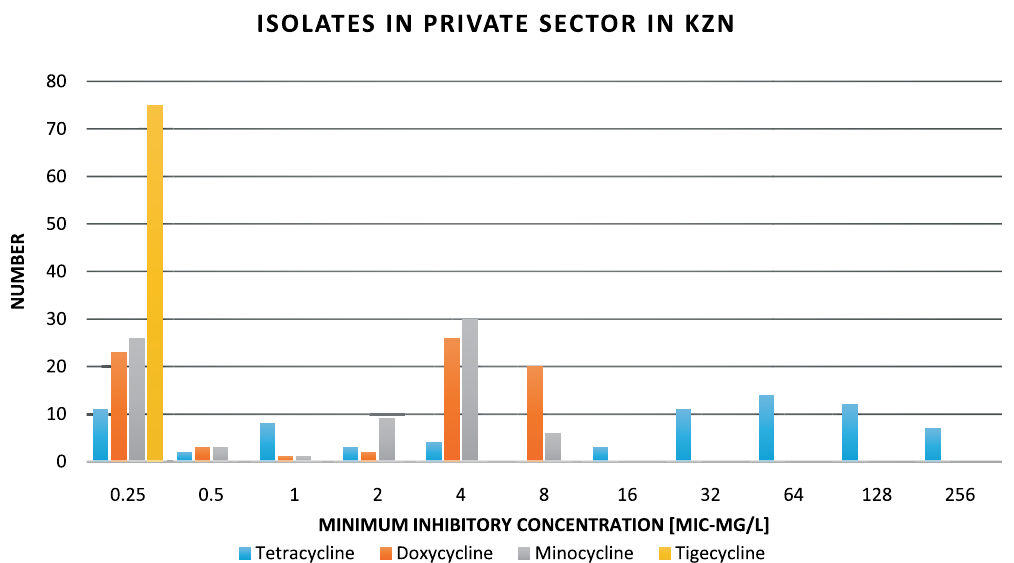
Fig. 1. MIC of tetracycline, doxycycline, minocycline and tigecycline to MRSA isolated from KZN Private Hospitals, SA.